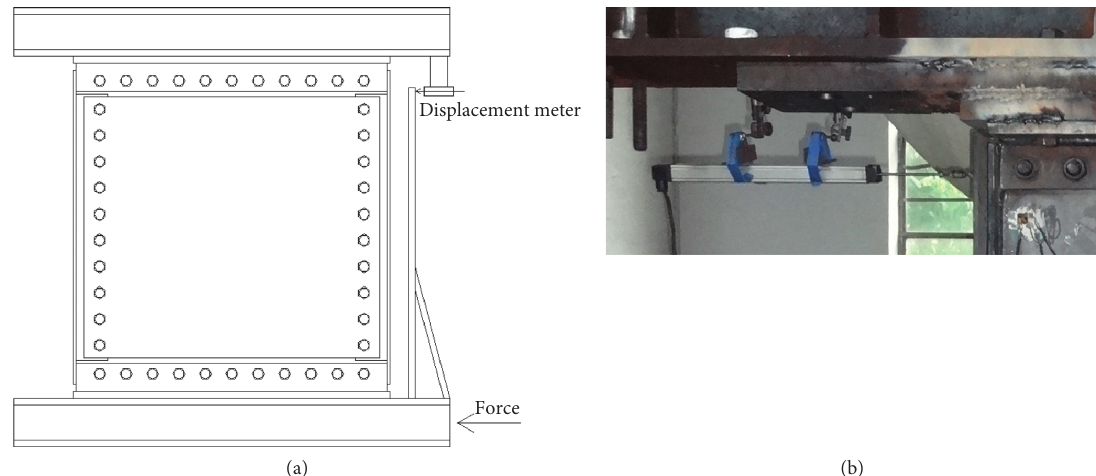
Figure 9: Layout of displacement meter (reversed side). (a) Schematic diagram of displacement meter. (b) Photograph of displacement meter.